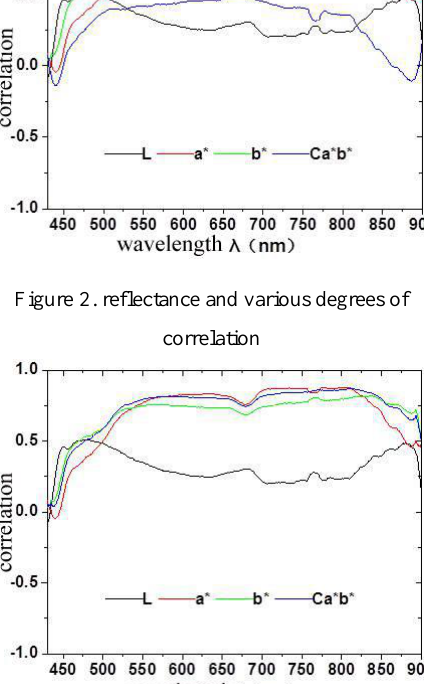
Figure 3. reflectance and the correlation of linear stretch